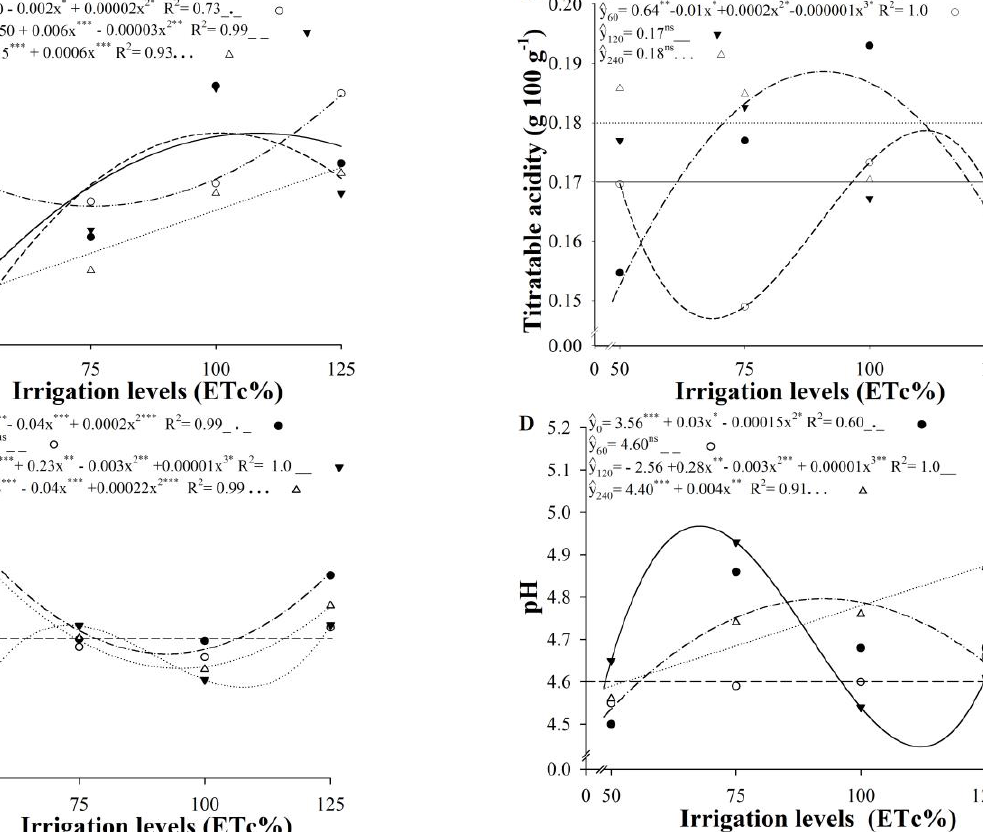
Figure 9. Titratable acidity of fig fruits in the 2018/2019 ( A ) and 2019/2020 ( B ) crop cycles, and pH of fig fruits in the 2018/2019 ( C ) and 2019/2020 ( D ) crop cycles as a function of irrigation levels and potassium doses under semiarid conditions in the 2018/2019 and 2019/2020 crop years. * Significant ( p < 0.05); ** Significant ( p < 0.01); *** Significant ( p < 0.001); ns Not significant ( p > 0.05).